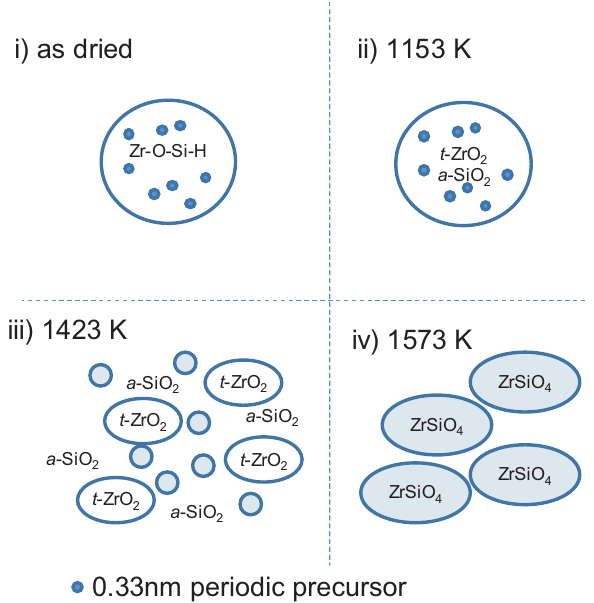
Figure 6. Schematic model for the formation of zircon from the ZrSiO 4 gel by